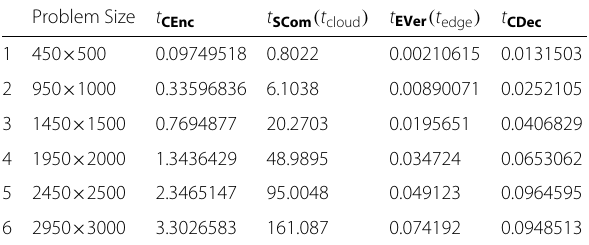
Table 7 Ax ≡ b mod 12289 with parameters